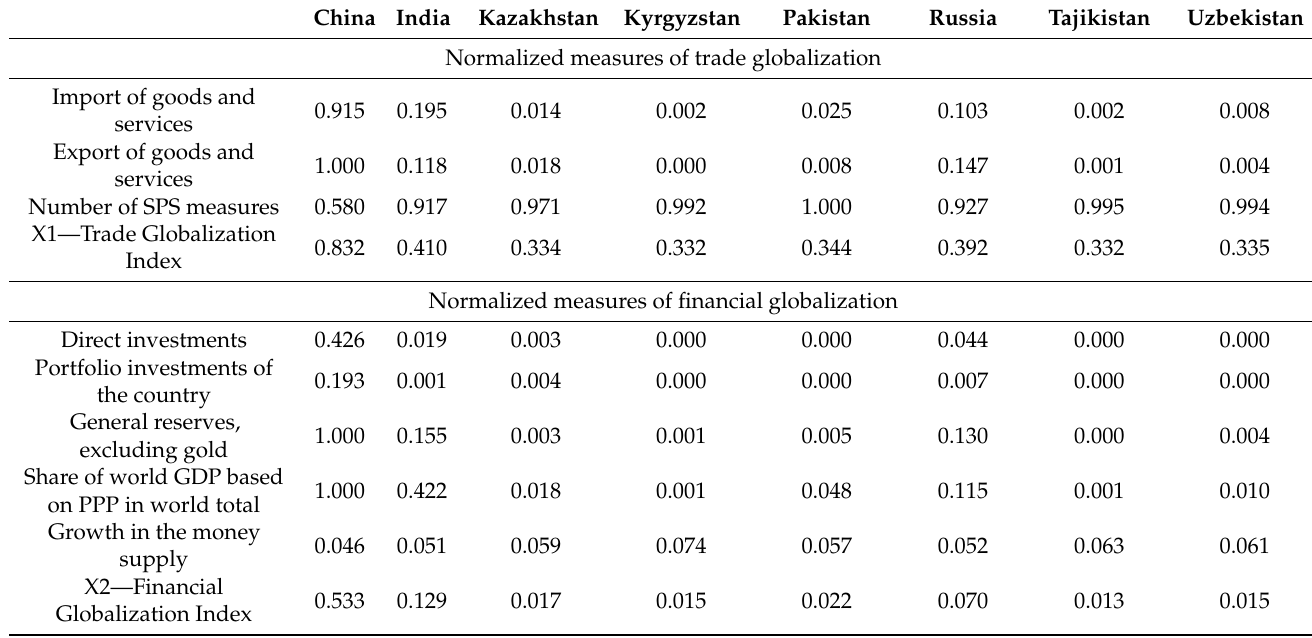
each direction of integration process (Table 4). Table 4. The results of normalized